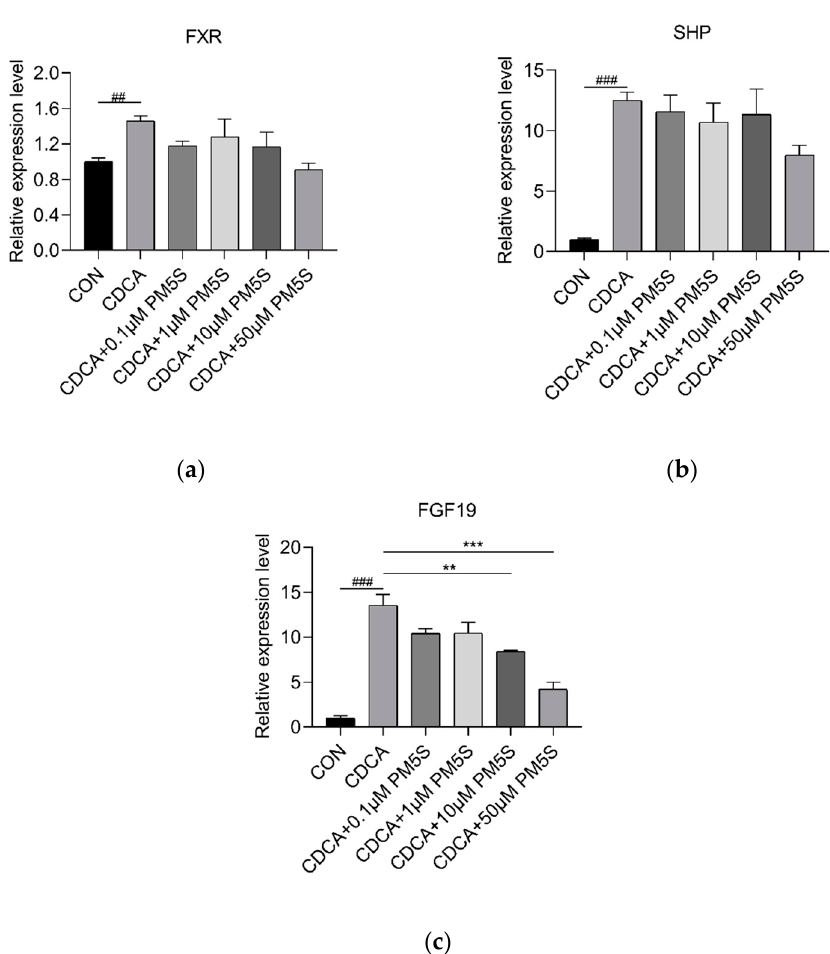
Figure 10. Relative expression of ( a ) cell medium TBA levels, ( b ) CYP7A1 , ( c ) NTCP , ( d ) OSTI ( e ) BSEP and ( f ) MDR3 in pig primary hepatocytes co-treated with CDCA (0, 50 μ mol/L) and PM5S (0, 0.1, 1, 10, 50 μ mol/L). n = 3/group. Data are shown as means ± SE, ## p < 0.01 for CON versus CDCA group, ### p < 0.001 for CON versus CDCA group. * p < 0.05 for CDCA versus CDCA and PM5S co- treatment group, ** p < 0.01 for CDCA versus CDCA and PM5S co-treatment group, *** p < 0.001 for CDCA versus CDCA and PM5S co-treatment group.